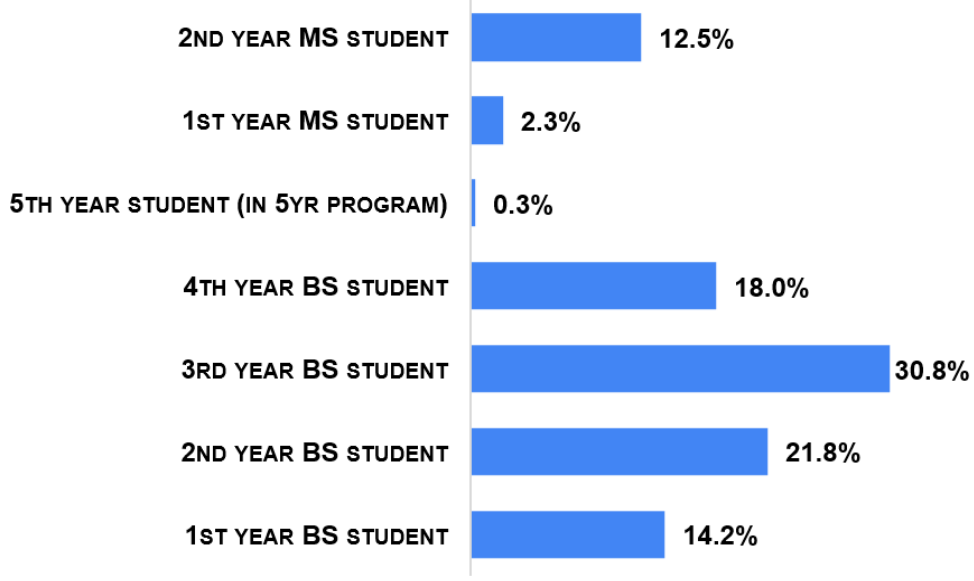
Figure 2. Distribution of students by courses of study.